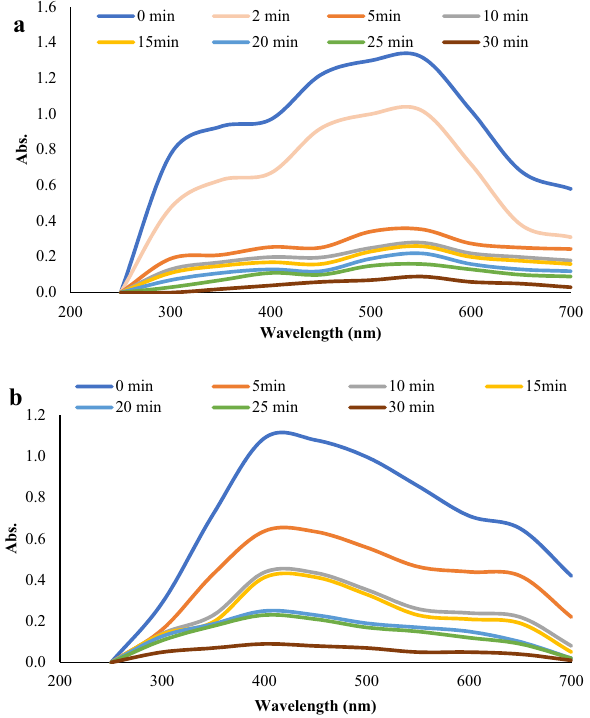
Fig. 14 Absorption spectra for the removal of a RR49, b RY15 dyes with EC